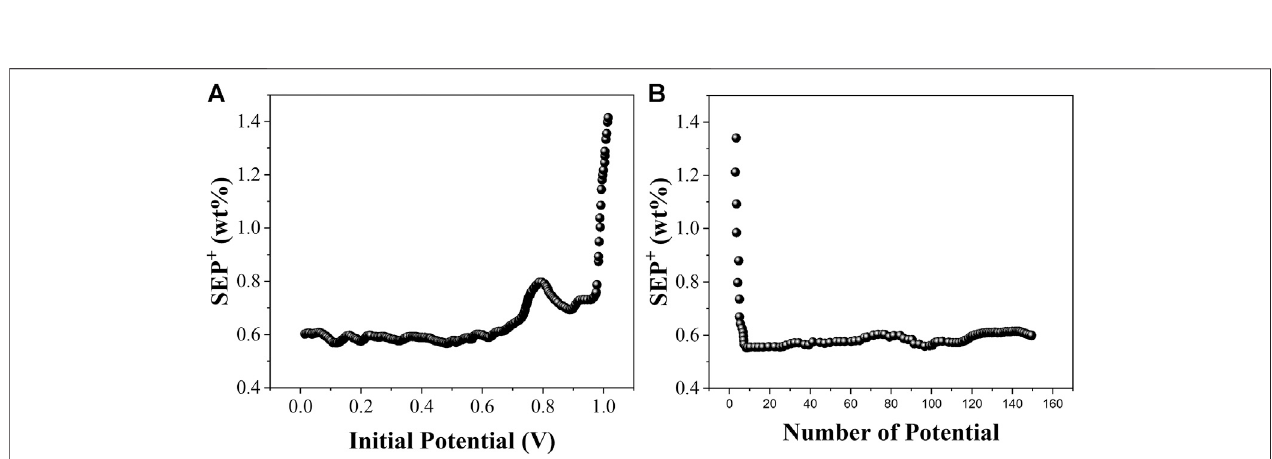
FIGURE 5 | The optimal SEP + corresponding to the starting potential I and the number of potentials N of the soil EC-PLS model for B location.